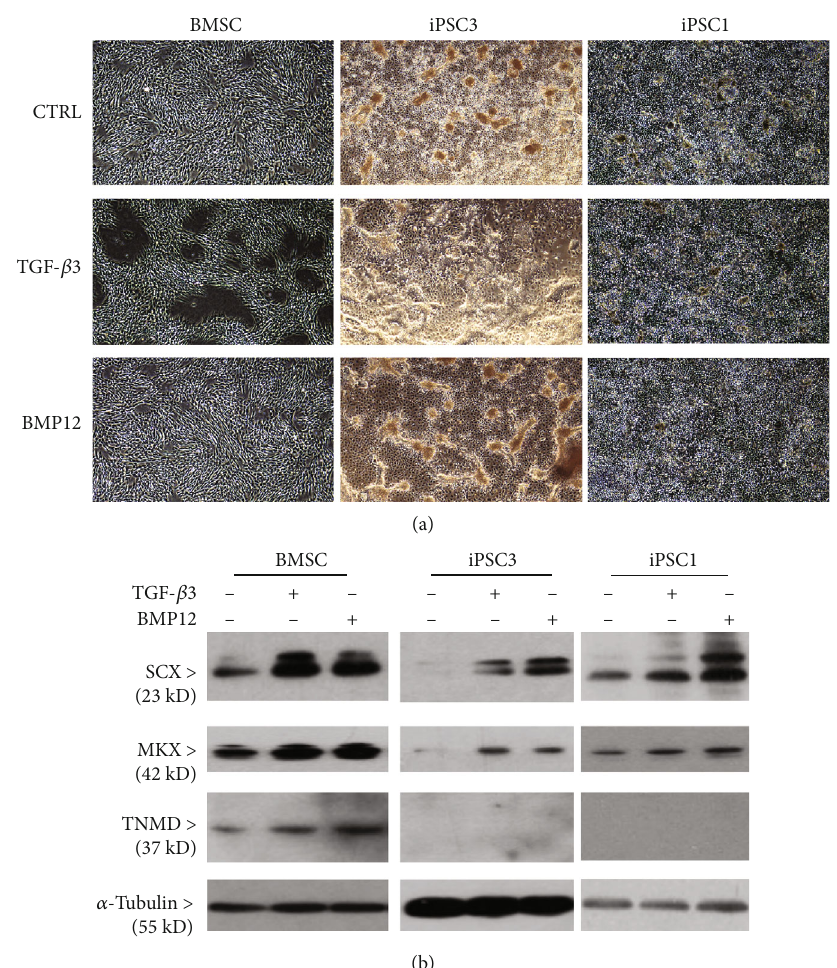
Figure 3: E ff ects TGF- β 3 and BMP12 on cell morphology and tenogenic protein expression. BMSCs and tow teno-iPSC clones (iPSC3 and iPSC1) were treated with vehicle medium, TGF- β 3 (20 ng/mL), or BMP12 (20 ng/mL) for 5 days. The cell morphology was imaged (a), and whole cell lysates were blotted for scleraxis (SCX), Mohawk (MKX), tenomodulin (TNMD), and α -tubulin